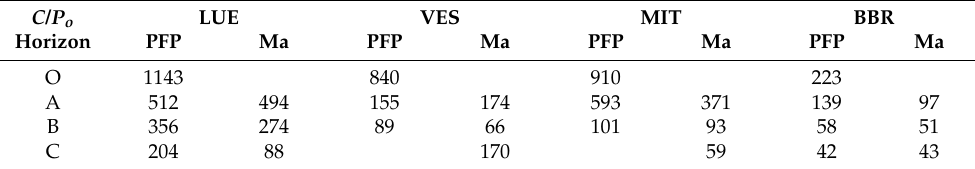
Table 3. Ratios of organic C to sum of organic P (Po) at four beech forest study sites in Germany for PFP (preferential flow pathways), Ma (soil matrix), and RC (root channel-PFP) samples. C/P o LUE VES MIT BBR Horizon PFP Ma PFP Ma PFP Ma PFP Ma O 1143 840 910 223 A 512 494 155 174 593 371 139 97 B 356 274 89 66 101 93 58 51 C 204 88 170 59 42